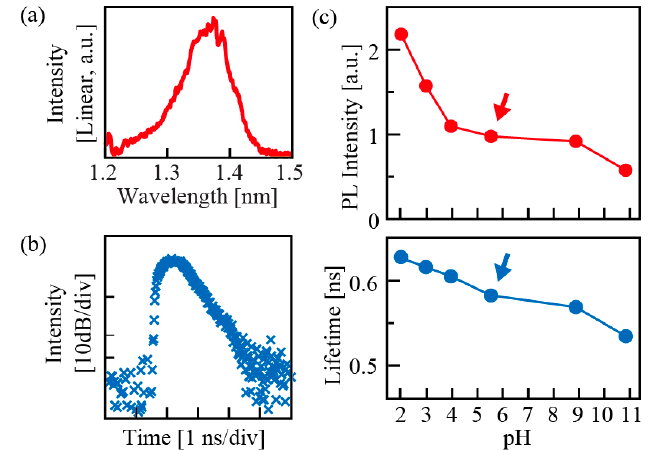
Figure 7. Photoluminescence (PL) characteristics when 300 nm-GaInAsP bulk layer on InP substrate with ZrO 2 coating is immersed in solution with various pHs. ( a ) PL spectrum. ( b ) Transient response of PL. ( c ) pH dependence of PL intensity and lifetime. The arrows correspond to ( a ) and ( b ), respectively.